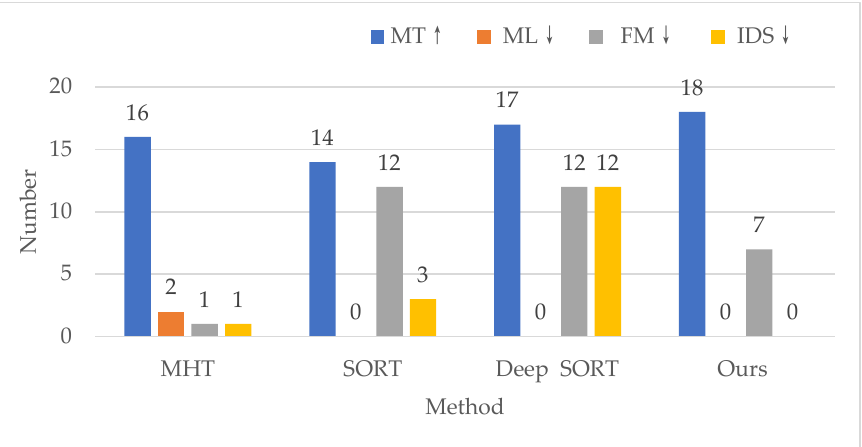
Figure 19. The comparison results of Siam-sort with other methods for the test set. “ ↑ ” means the larger the better and “ ↓ ”means the smaller the